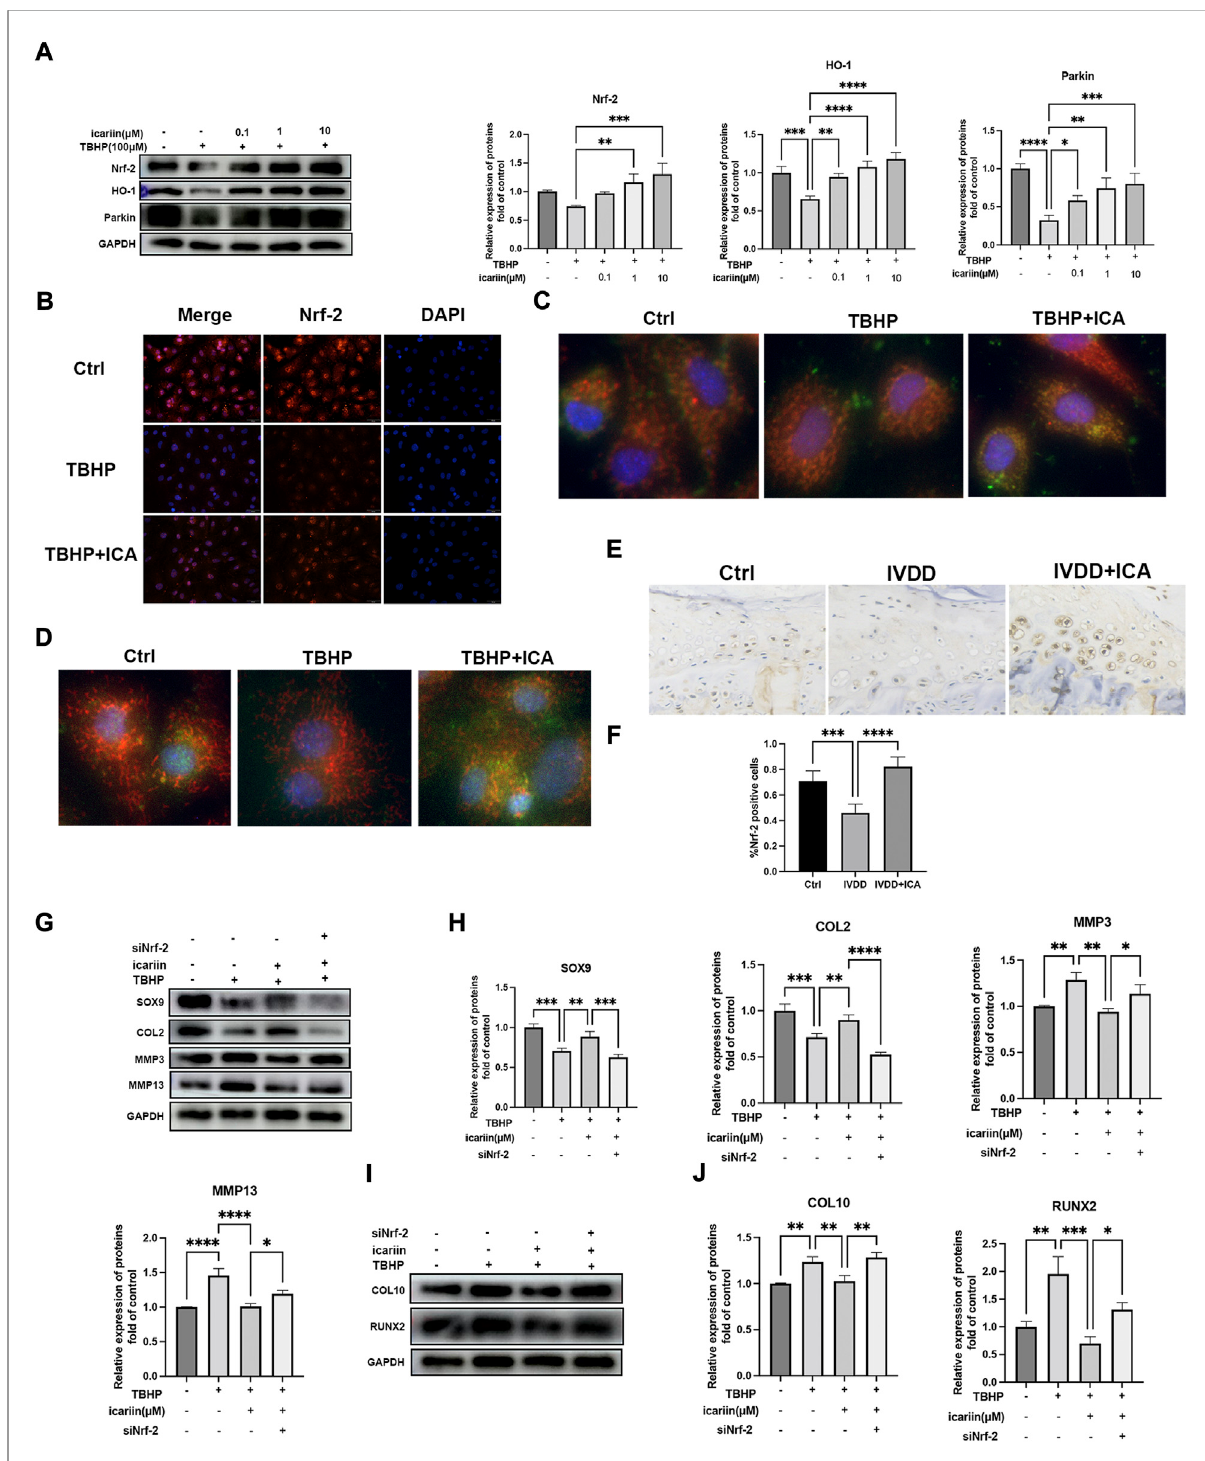
FIGURE 6 ICA protected against TBHP induced endplate degeneration and chondrocytes apoptosis via activating the Nrf-2/HO-1 pathway. (A) Chondrocytes were treated with TBHP (100 μ M) and ICA (0.1, 1, and 10 μ M) for 24 h, and Western blot was conducted to examine the protein levels ofNrf-2, HO-1, andParkin.The band densities ofNrf-2, HO-1, andParkinwerequanti fi edand normalized to control. (B) Chondrocytesweretreated with TBHP (100 μ M) with or without ICA (10 μ M) for 24 h and immuno fl uorescence staining of Nrf-2 was conducted. Scale bar = 20 µm. (C) Chondrocytes were treated with TBHP (100 μ M) with or without ICA (10 μ M) for 24 h and immuno fl uorescence staining was conducted to examine the expression and localization of Parkin (green) and mitochondria (red). (D) Chondrocytes were treated with TBHP with or without ICA (10 μ M) for